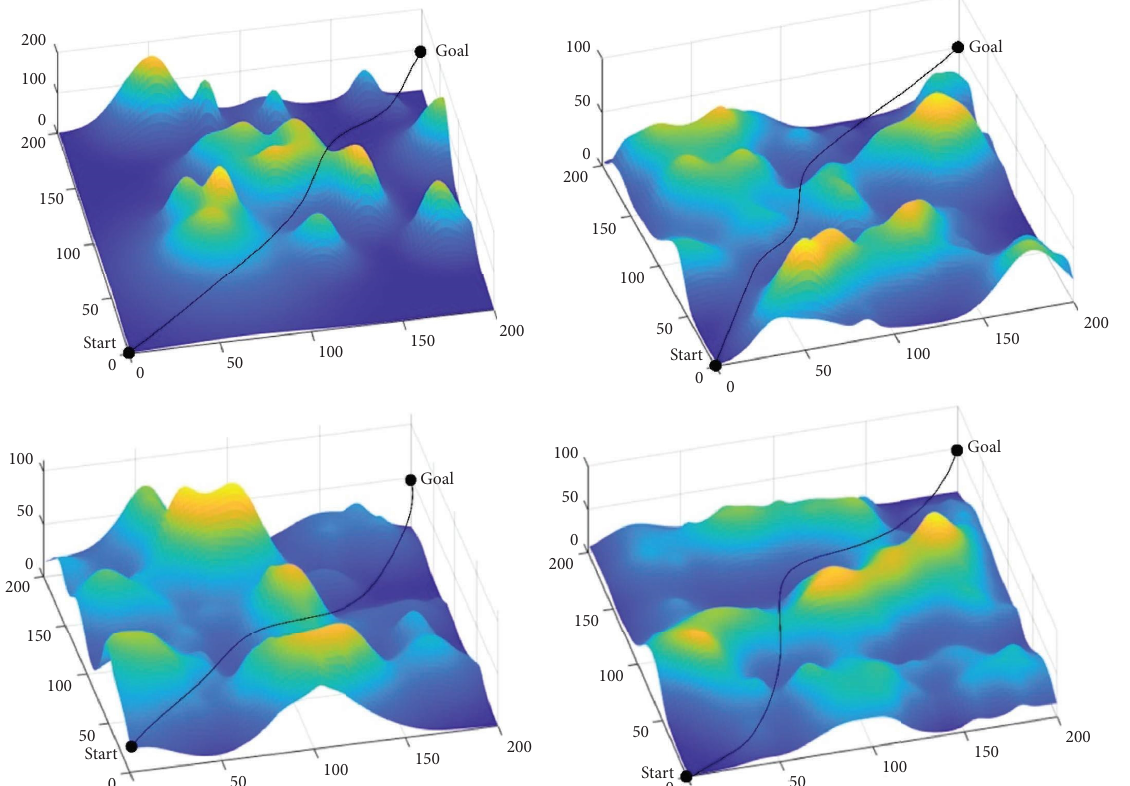
Figure 8: Tests of four diferent complexity